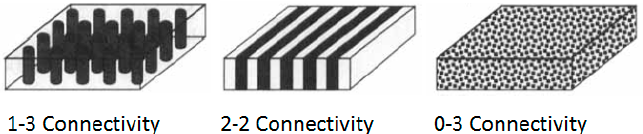
Figure 4. Common piezocomposite configurations used in transducers and their connectivity [103]. Reprinted by permission of the publisher (Taylor & Francis Ltd, http: // www.tandfonline.com ). Reprinted by permission of the publisher (Taylor & Francis Ltd, http://www.tandfonline.com ).